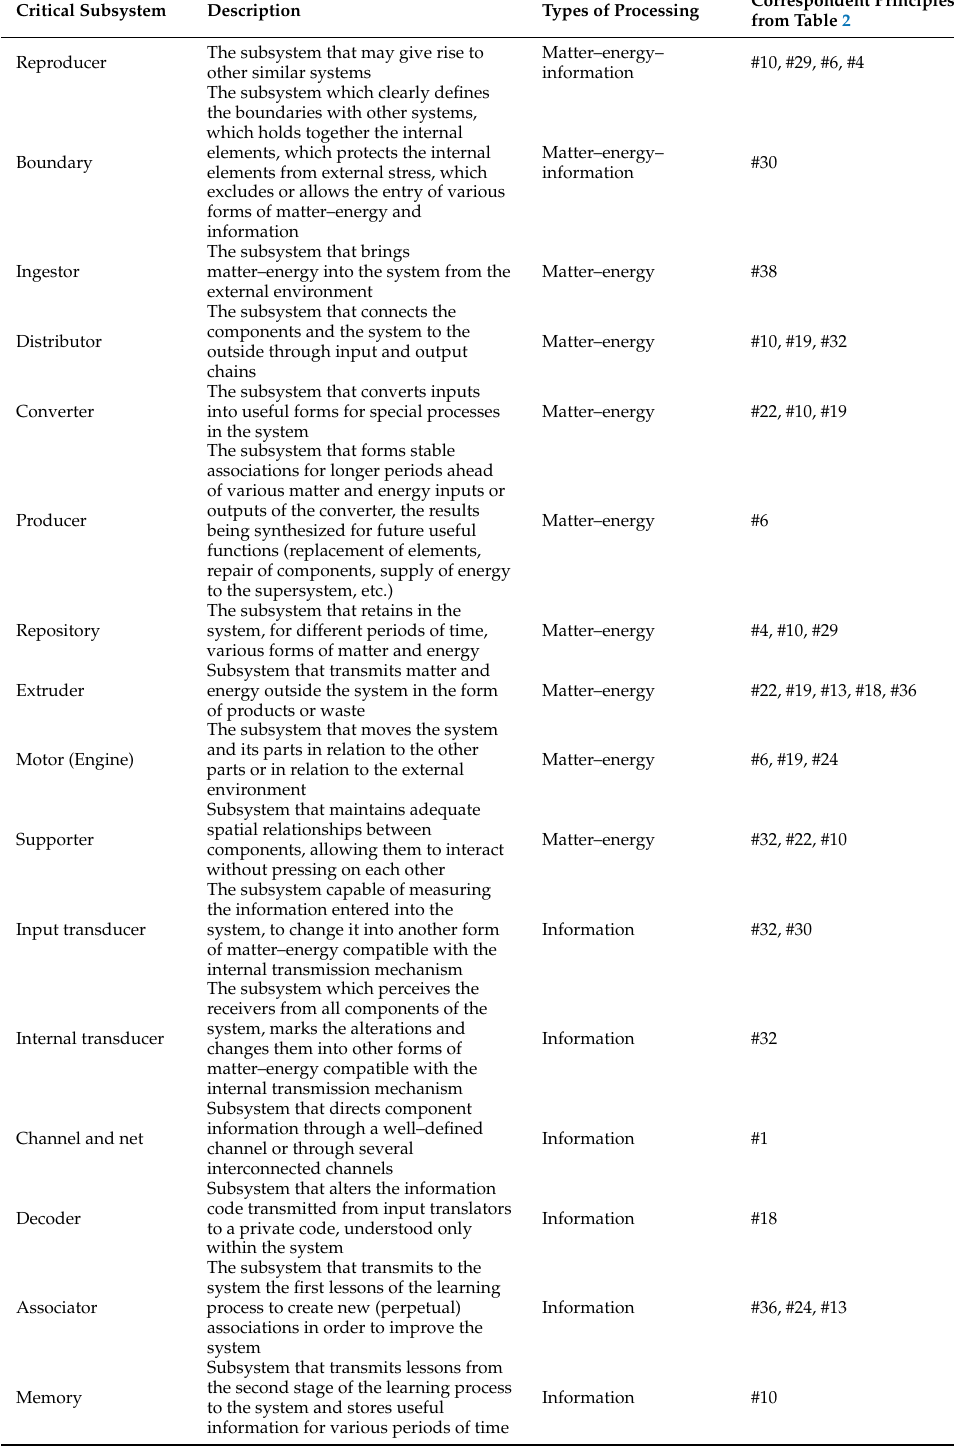
Table 3. Subsystems of a living